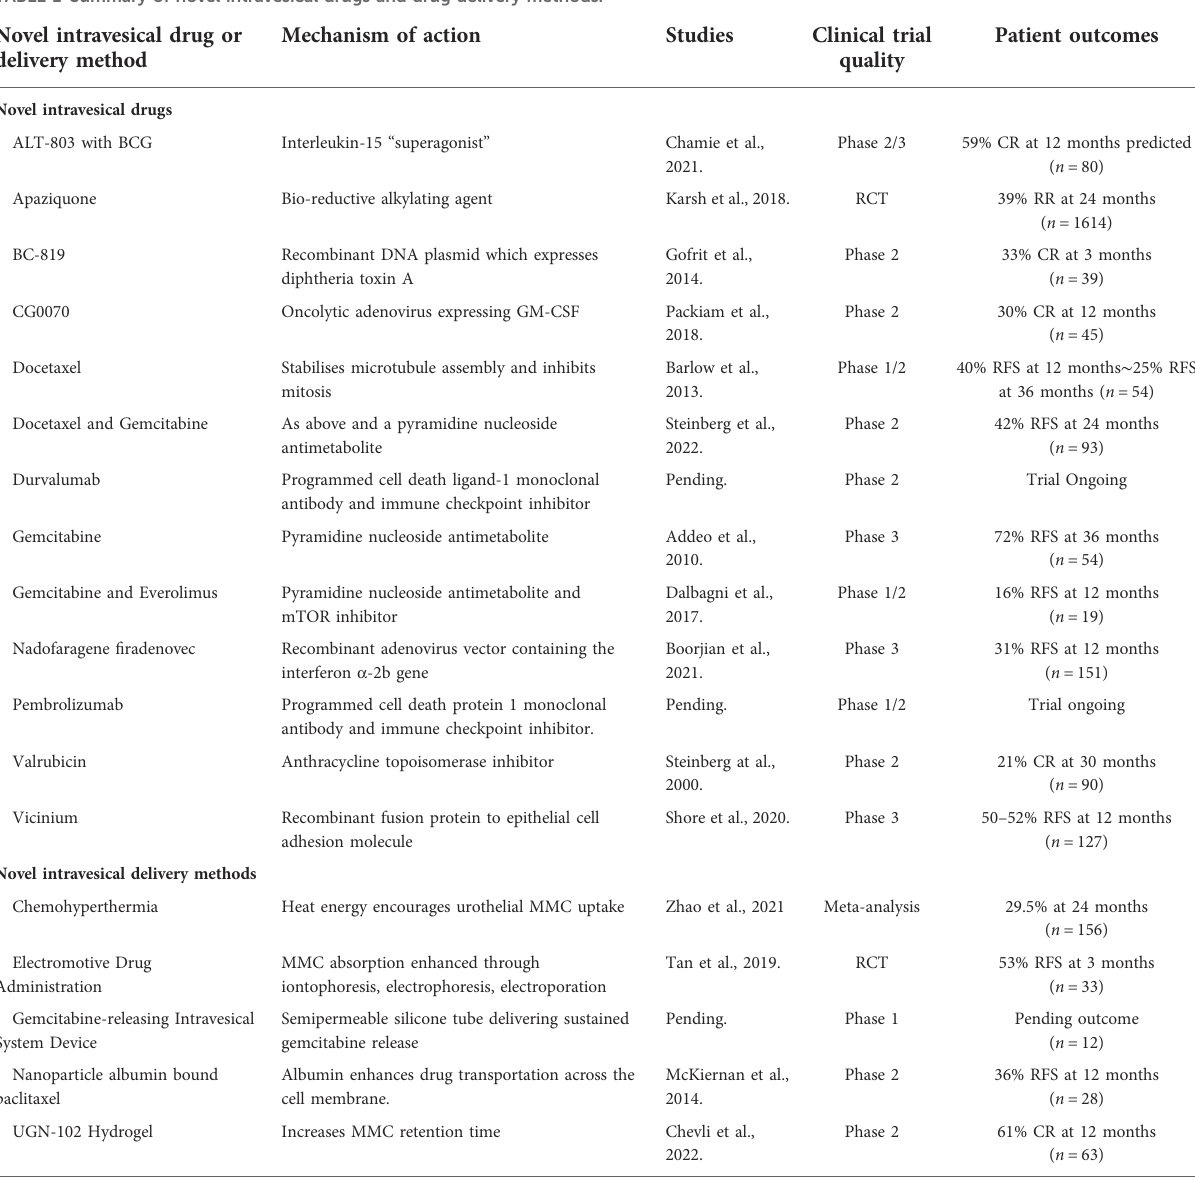
TABLE 1 Summary of novel intravesical drugs and drug delivery